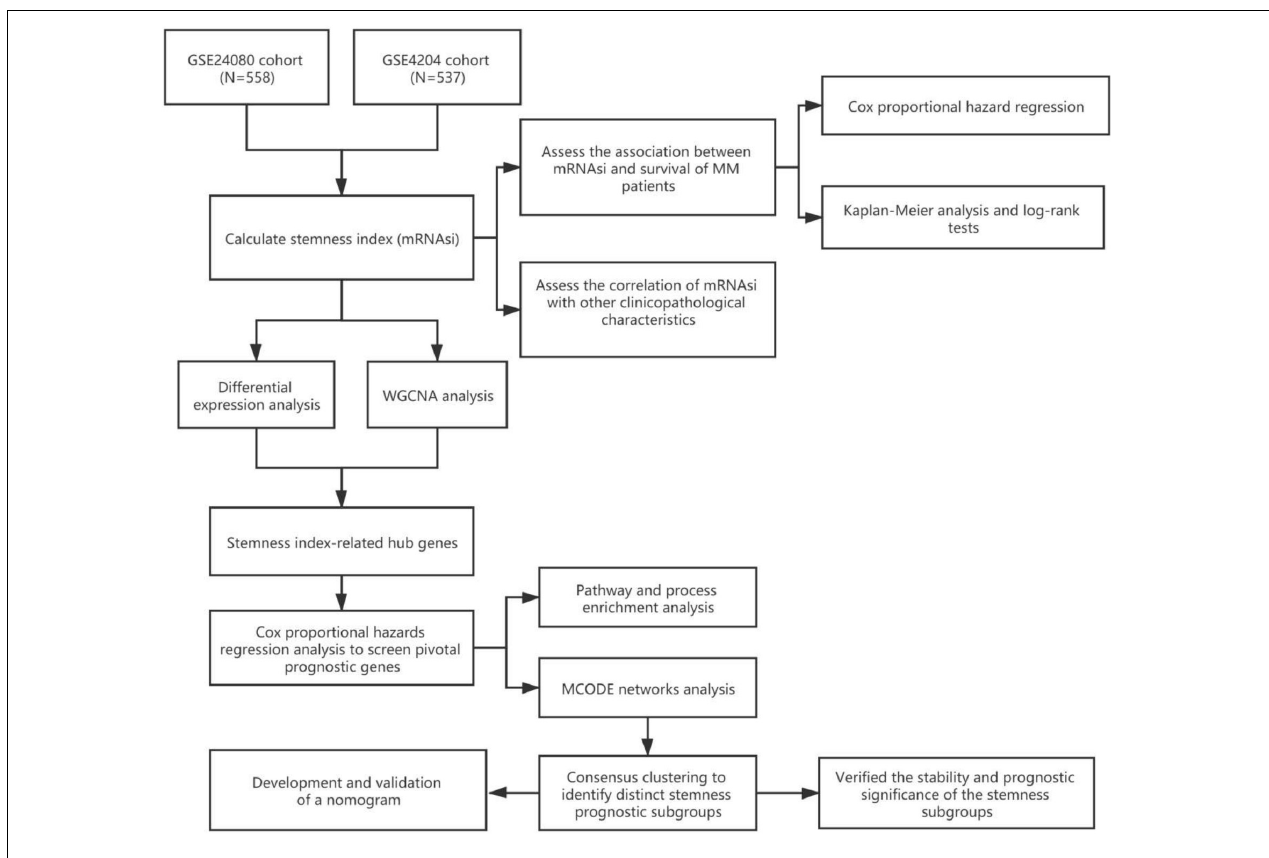
FIGURE 1 | Workflow of this